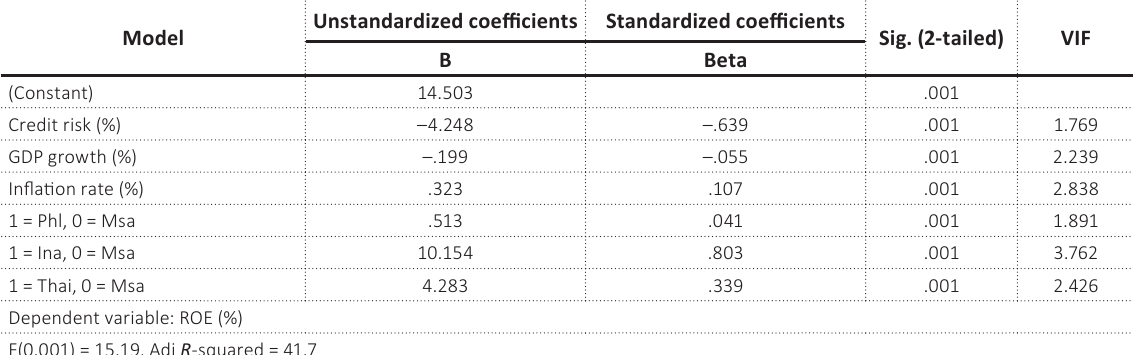
Table 6. Regression results on ROE